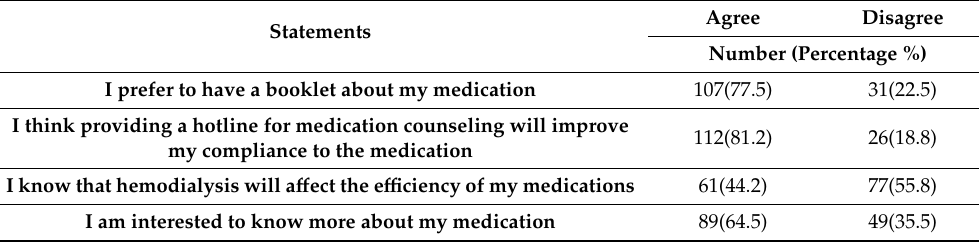
Table 4. Opinion of patients toward statements.